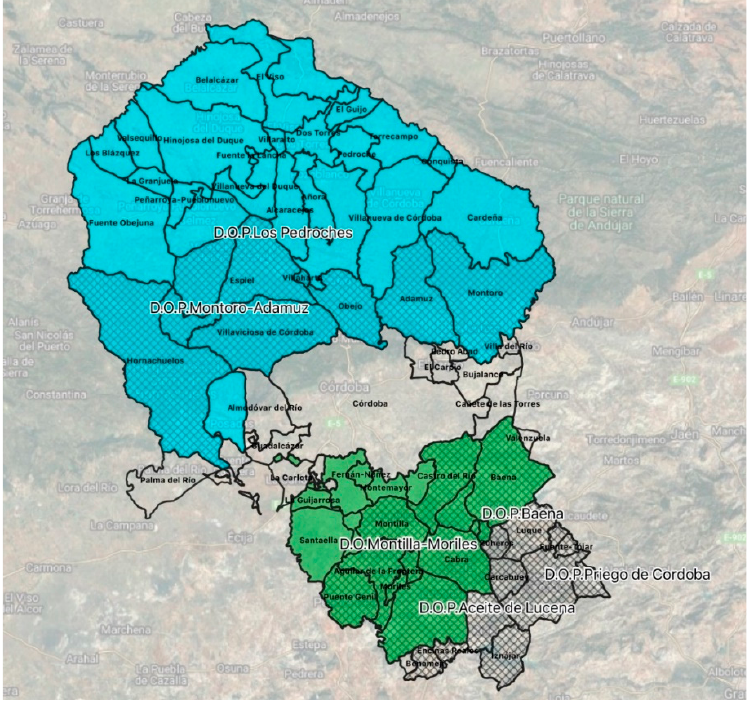
Figure 1. Geographical location of PDOs in the province of Córdoba. Source: own elaboration. In the figure, blue represents the Pedroches ham PDO; green represents the Montilla- Moriles wine PDO, and the hatched area represents the four olive oil PDOs.